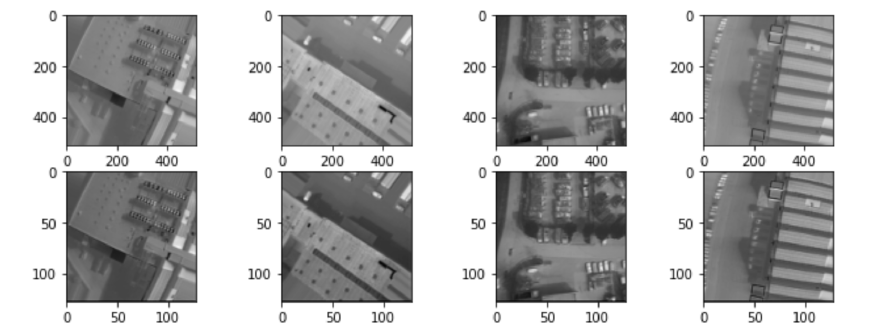
Figure 11. Encoder compressed output image before quantization on the first row and post- quantization encoder output on the